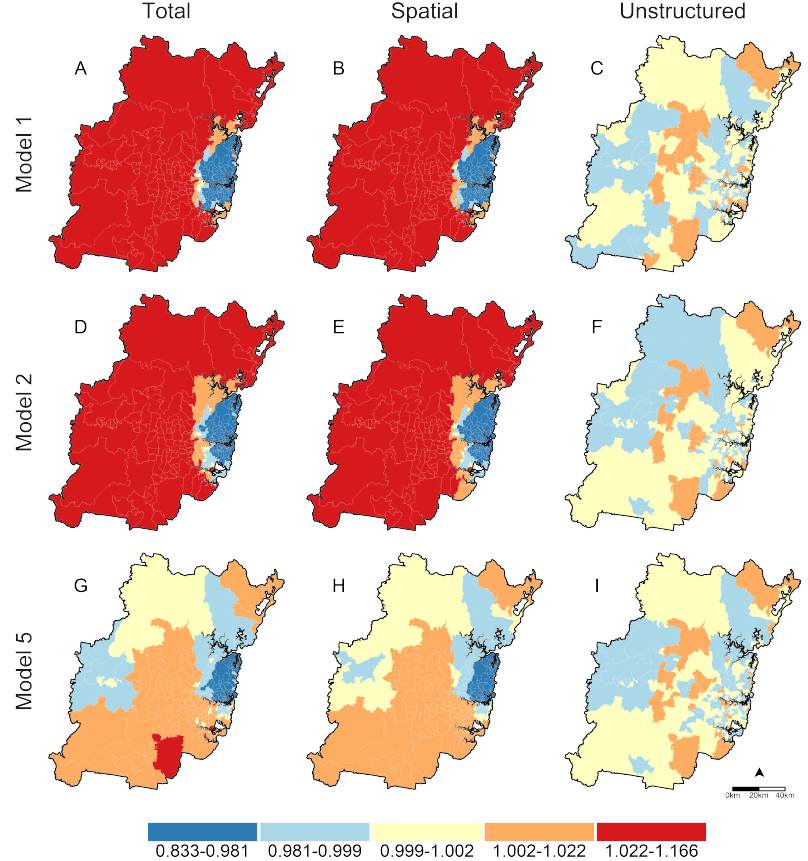
Figure 1. Total, Spatial and Unstructured prevalence ratios for overweight body mass in Sydney postal areas. Total prevalence ratios are derived by exponentiating the sum of spatial ( s ) and unstructured ( u ) random effects; Spatial and Unstructured prevalence ratios are obtained by exponentiating individual s and u components, respectively. Total, Spatial, and Unstructured prevalence ratio estimates are reported in maps ( A – C ) for Model 1, maps ( D – F ) for Model 2, and maps ( G – I ) for Model